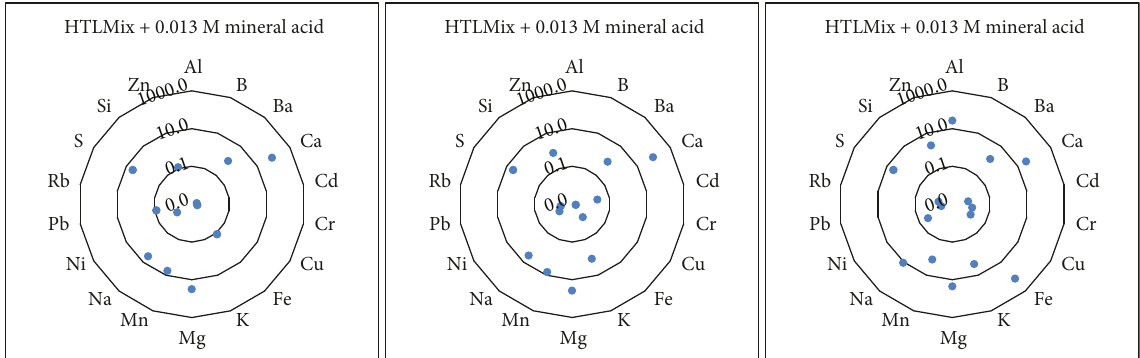
Figure 9: Elemental composition (in ppm) of each leachate reacted with the mixture of 0.01M HCl and 0.003M HNO under 200bar pressure in Ti batch reactors (absence of data points re fl ects concentrations below the limits of